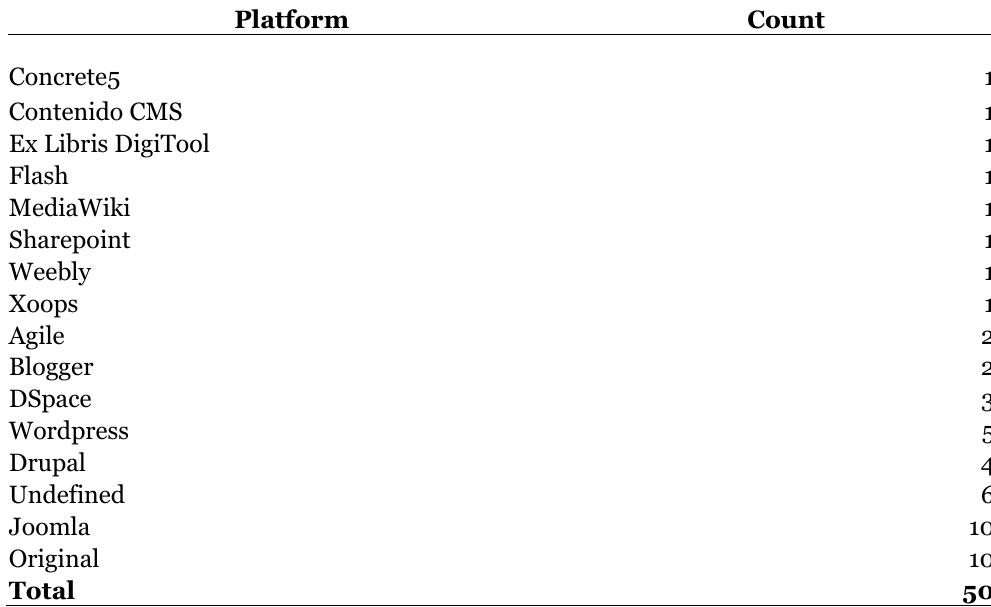
Systems Used for